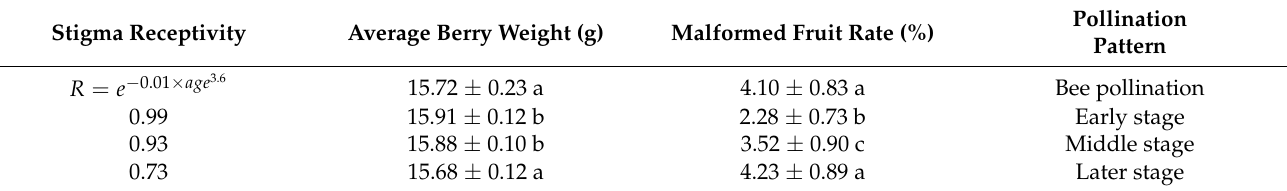
Table 4. Impacts of stigma receptivity in bee pollination simulation.